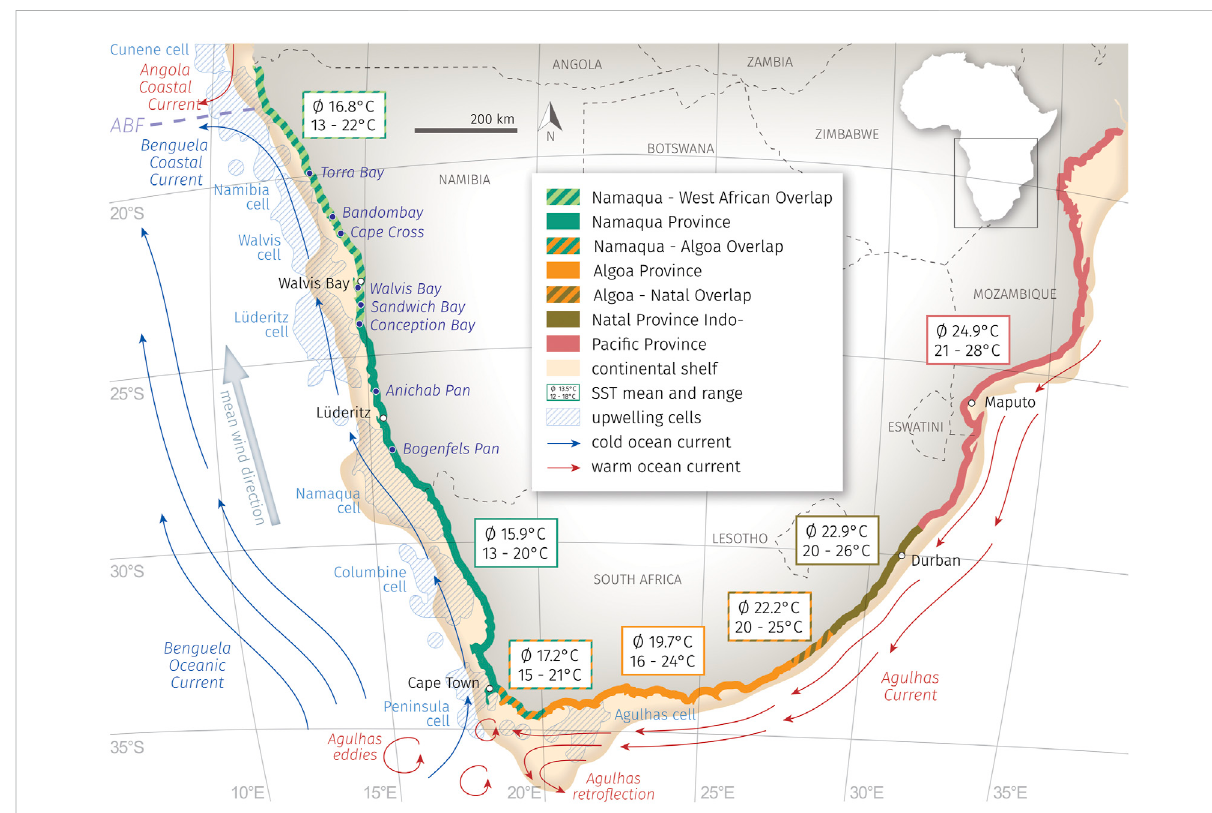
FIGURE 1 Location of studied (paleo-)lagoons (this study) and the coastal Anichab Pan (Compton, 2007) and Bogenfels Pan (Compton, 2006) in the contextoftheoceanographicsituationaroundsouthernAfricawiththewarmwatermassesofAgulhasCurrentandAngolaCoastalCurrent(red)and the cool Benguela Current with the Benguela Coastal Current (both blue), the todays location of the Angola-Benguela-Front (ABF, violett), mean wind direction and resulting upwelling cells (light blue, hachured shapes, after Lutjeharms and Meeuwis, 1987). Marine biogeographic provinces/ecoregions along the southern African coastlines (modi fi ed after Kilburn and Rippey, 1982; Heyns-Veale et al., 2022) with coastal SST (mean and seasonal range, after CERSAT: